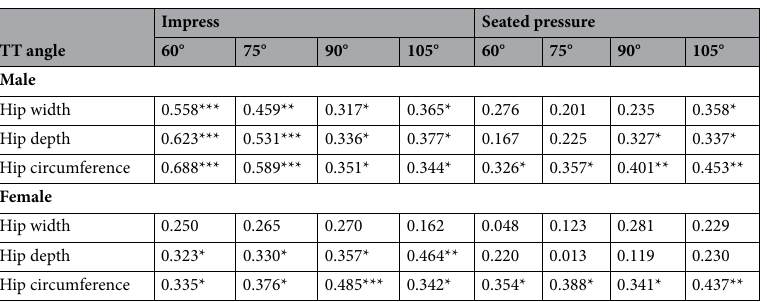
Table 5. Correlation coefficients (r) between external ischial tuberosity width and three hip dimensions for various test combinations. * p < 0.05; ** p < 0.01; *** p <